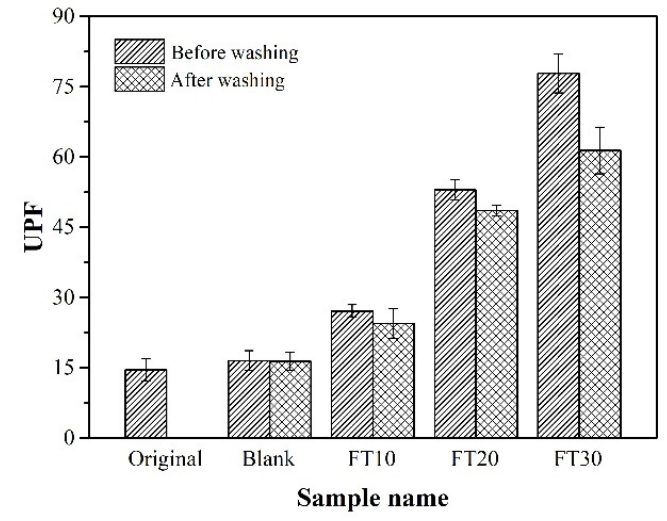
Figure 11. The anti-ultraviolet performance of functional textile and durability. Table 2. Anti-ultraviolet and mechanical properties of functional textile.